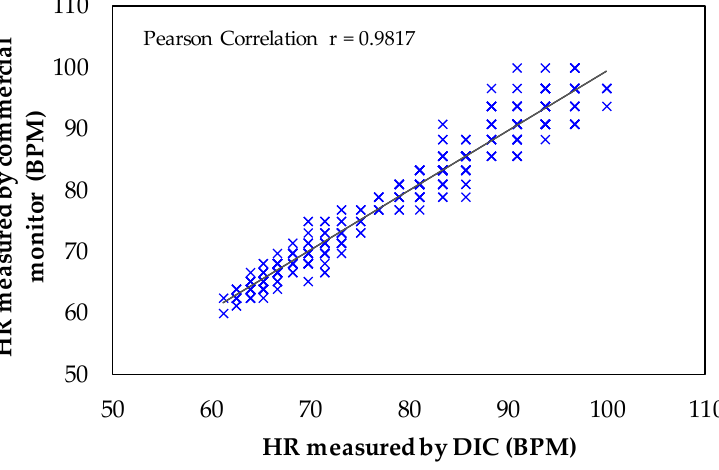
Figure 10. Scatter plot of the peak-to-peak HR measured by the DIC and by the commercial monitor.